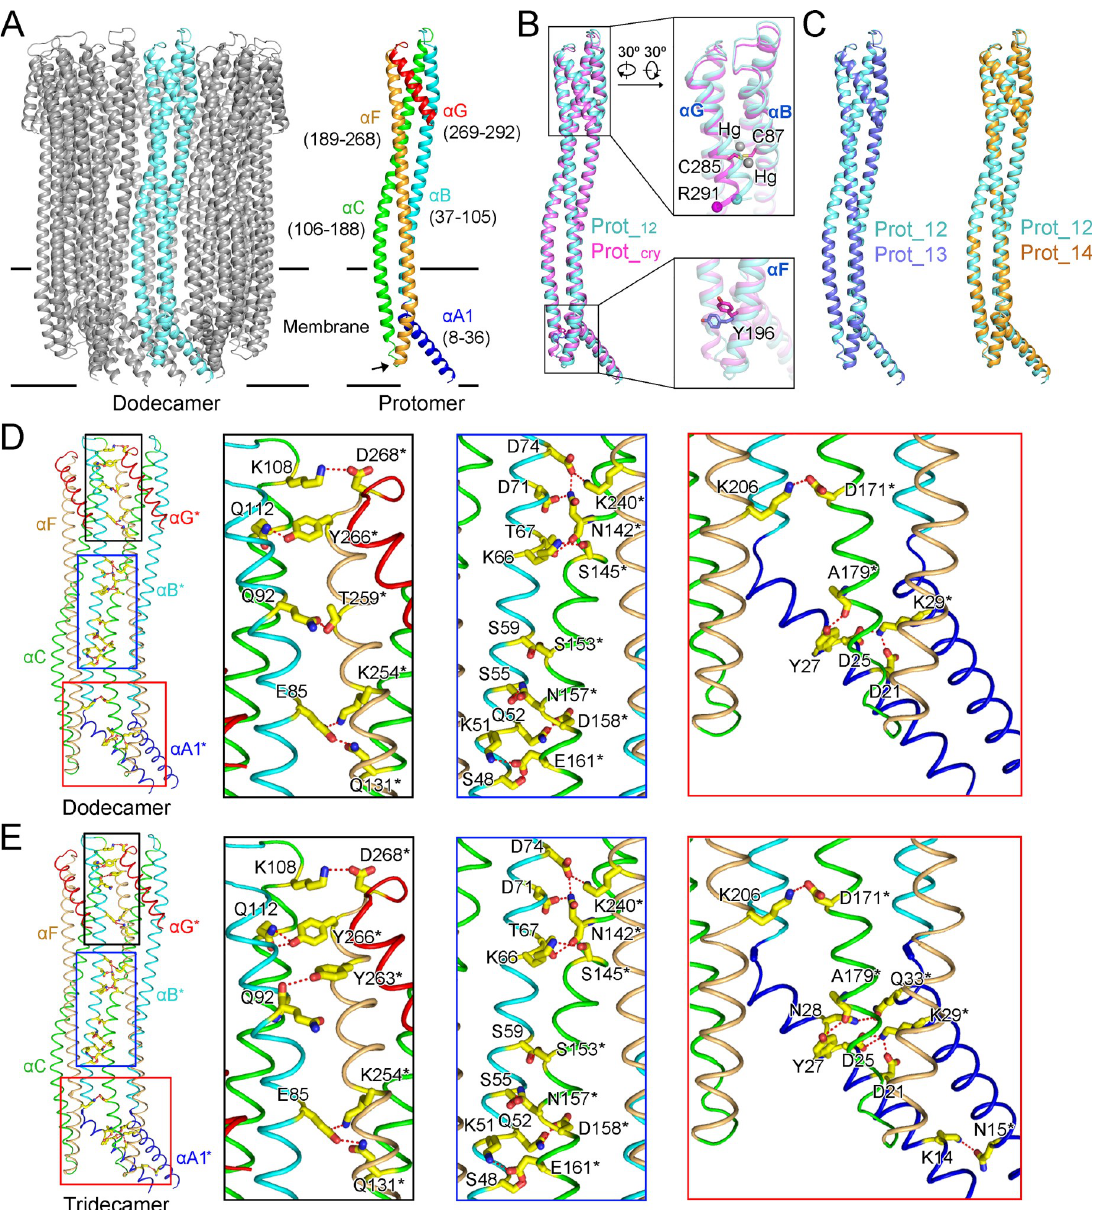
Fig 2. Structure comparison of the ClyA dodecamer, tridecamer, and tetradecamer complexes. ( A ) Illustration of secondary elements within one protomer from the dodecamer. Five α -helices ( α A1, α B, α C, α F, and α G) within one protomer (left) are colored in blue, cyan, green, orange and red (right). The corresponding amino acid boundaries are indicated, with the short loops divided and assigned to the linked helices for simplicity. The turning point of α C and α F is indicated by an arrow. The same coloring paradigm is applied in Figs 2D , 2E and S7 . ( B ) Comparison of one protomer from the dodecamer (Prot_12, in cyan) with that from the crystal structure (Prot_cry, in magenta). The PDB accession code for the crystal structure is 2WCD. The two mercury atoms in the crystal structure are shown as grey balls. C α atoms of R291 are indicated as balls. ( C ) Comparison of Prot_12 with a protomer from the tridecamer (Prot_13, in blue) and the tetradecamer (Prot_14, in orange). ( D , E ) Extensive hydrogen bonds and salt bridges mediate the interaction between neighboring protomers in the dodecamer and the tridecamer. Residues involved are labeled and shown as sticks. Residues from different protomers are distinguished with or without “ � ”.